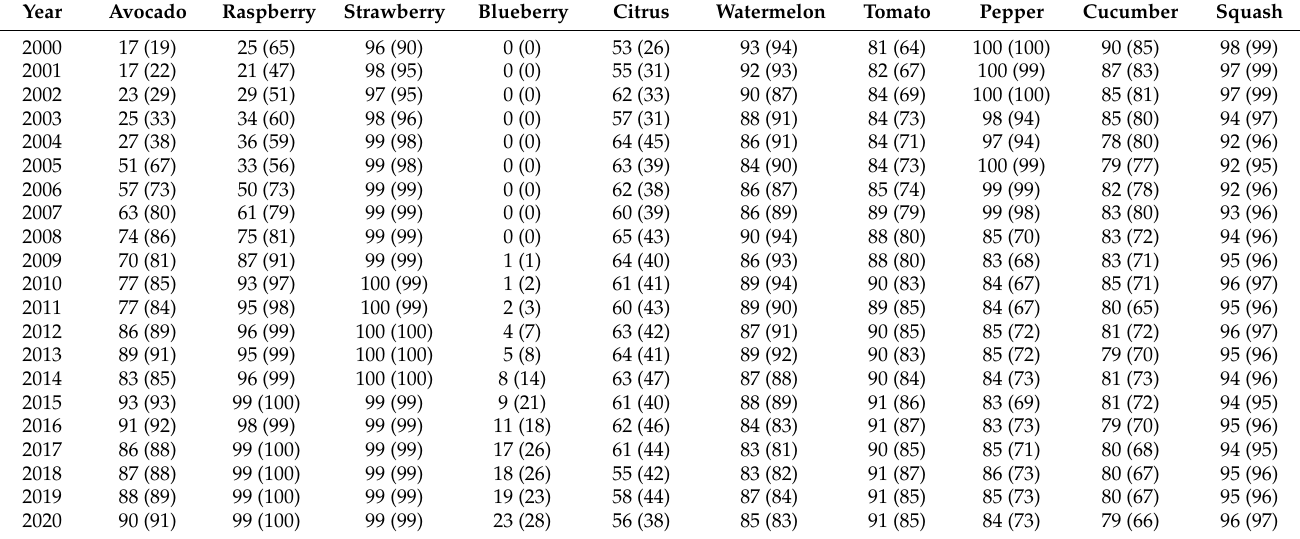
Table 1. Share of imports (%) of Mexican fruit and vegetable from 2000 to